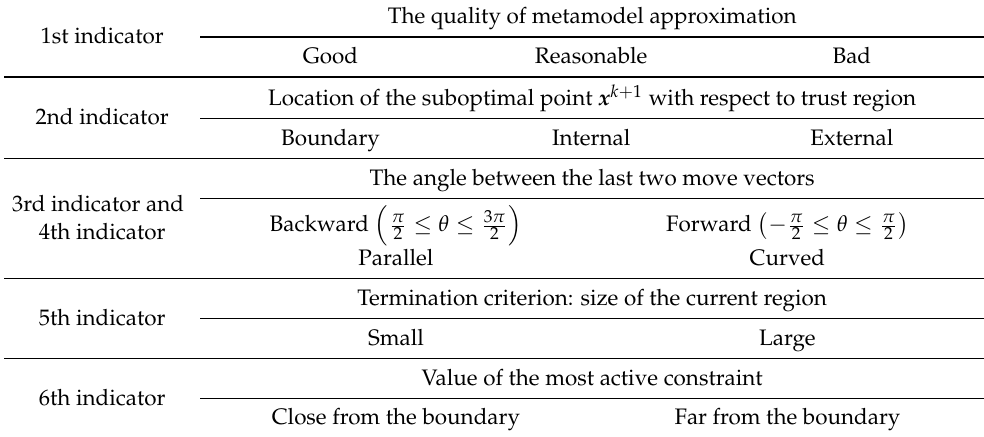
Table 1. Six indicators in